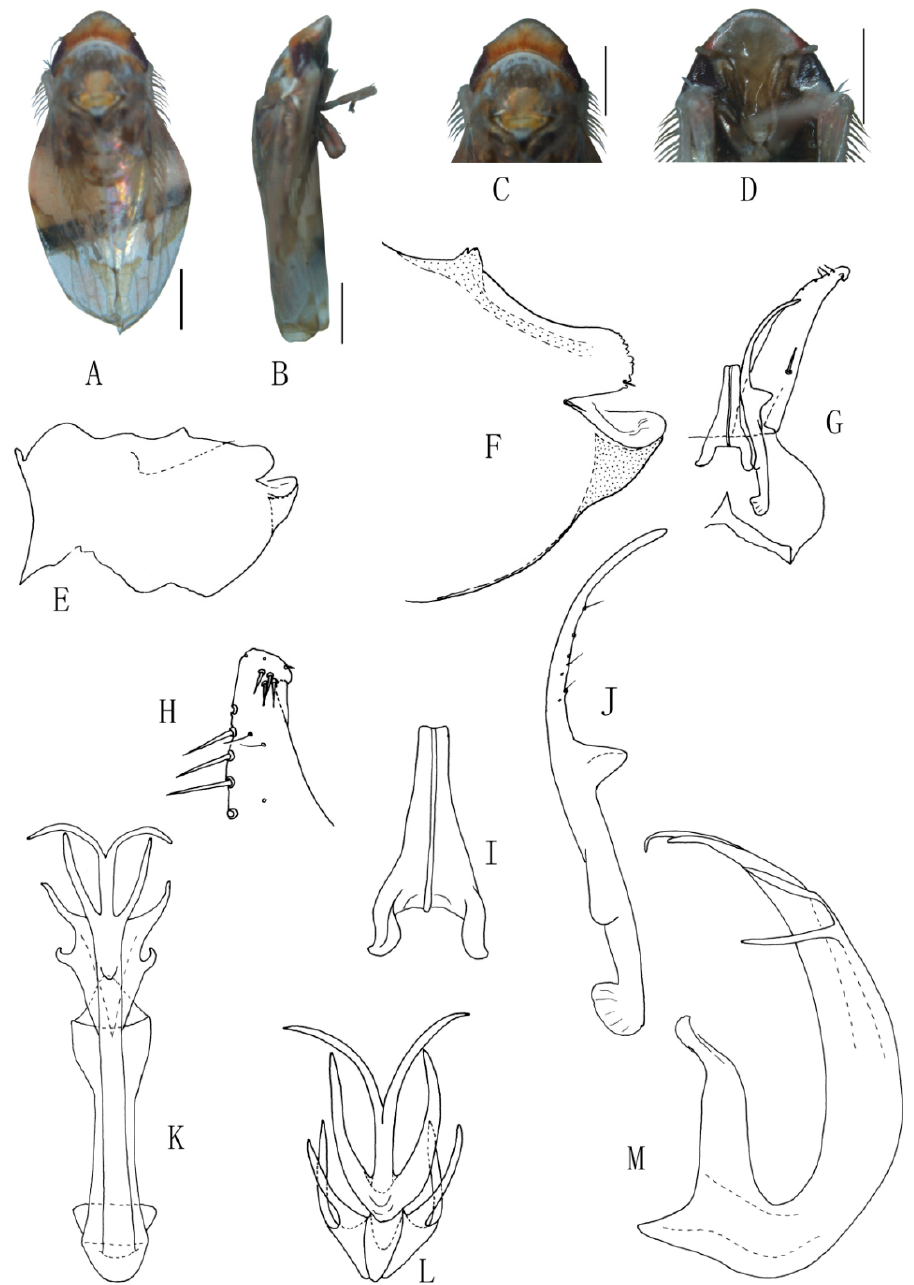
Figure 17. Eurhadina ( Singhardina ) gracilifurca sp. nov. : ( A ) habitus, dorsal view; ( B ) habitus, lateral view; ( C ) head and thorax, dorsal view; ( D ) face; ( E ) male pygofer side, lateral view; ( F ) hind part of pygofer, lateral view; ( G ) subgenital plate, connective, paramere and sternite IX, dorsal view; ( H ) apex of subgenital plate, dorsal view; ( I ) connective, dorsal view; ( J ) paramere, dorsal view; ( K ) aedeagus, posterior view; ( L ) apex of aedeagal shaft, dorsal view; and ( M ) aedeagus, lateral view. Scale bars: 0.5 mm. Eurhadina ( Singhardina ) lata Zhang et Huang sp. nov. (Figure 18A–M) Body and face reddish orange. Crown with a creamy longitudinal fascia, remainder reddish orange. Pronotum with a creamy longitudinal fascia and two triangular patches